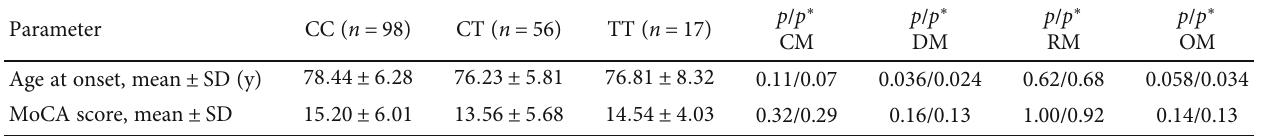
Table 4: Analysis of association between MMP2 rs243865 (-1306 C/T) genotypes and clinical fi ndings.